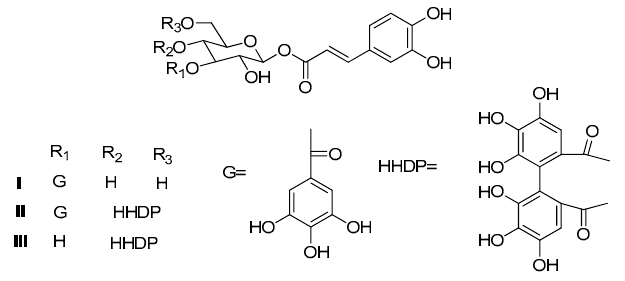
Figure 1. Chemical structures of three glucose esters from B. simaoensis .